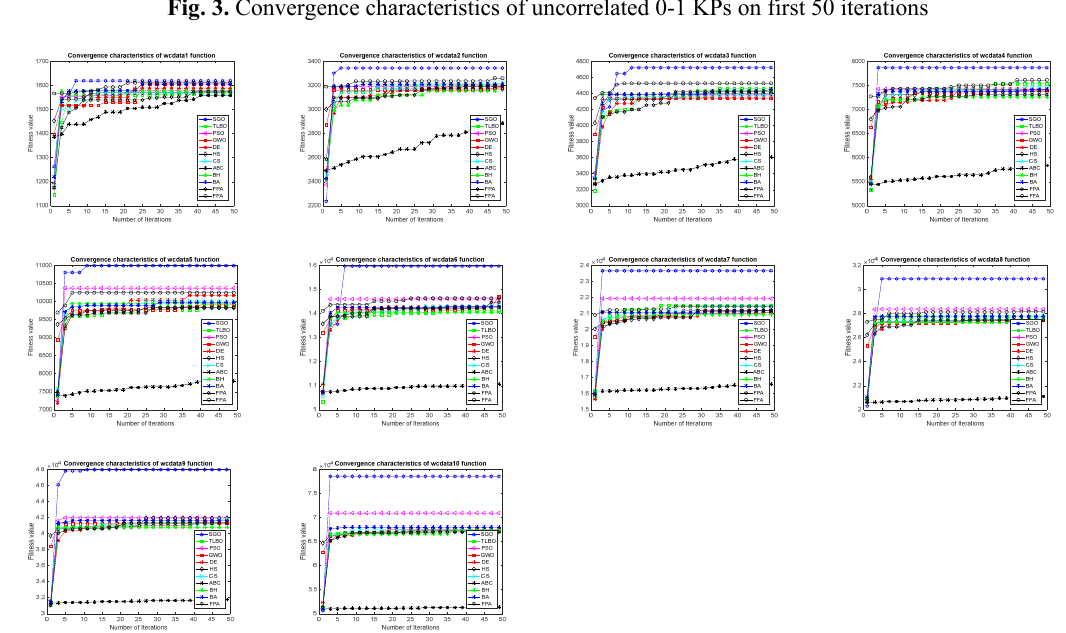
Fig. 3. Convergence characteristics of uncorrelated 0-1 KPs on first 50 iterations